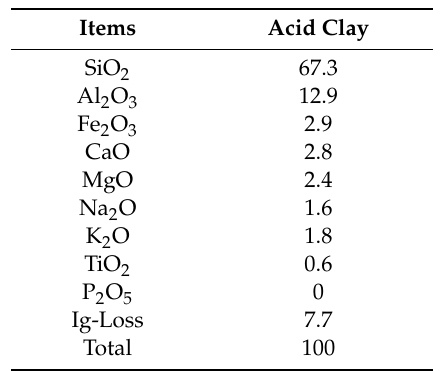
Table 1. Compositions of the acid clay (wt